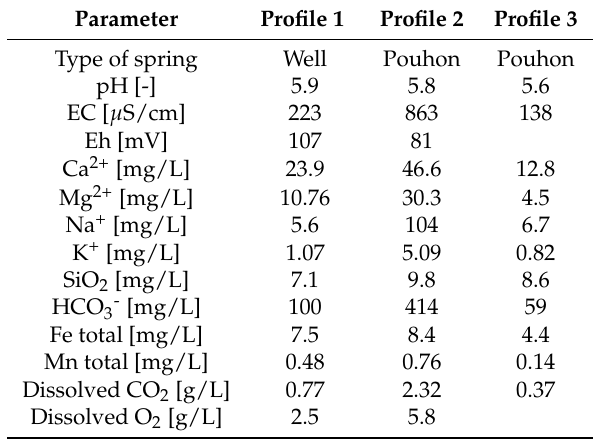
Table 3. Hydrochemistry data for the springs and the well upon which the profiles are located. Parameter Profile